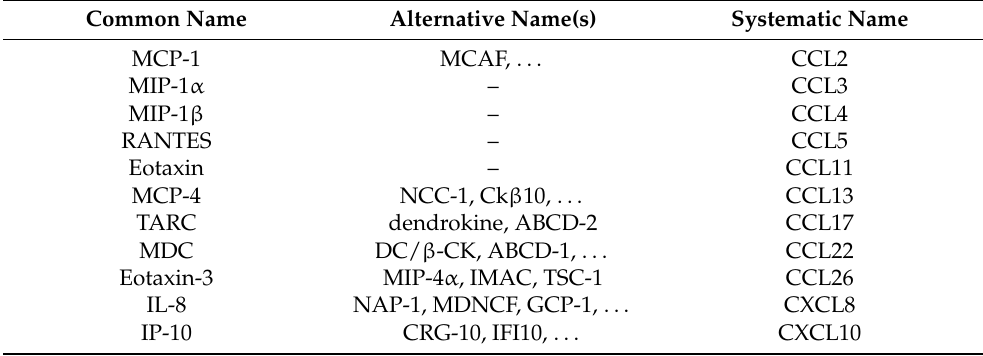
Table 4. Cytokine/chemokine nomenclature. As for many cytokines and chemokines